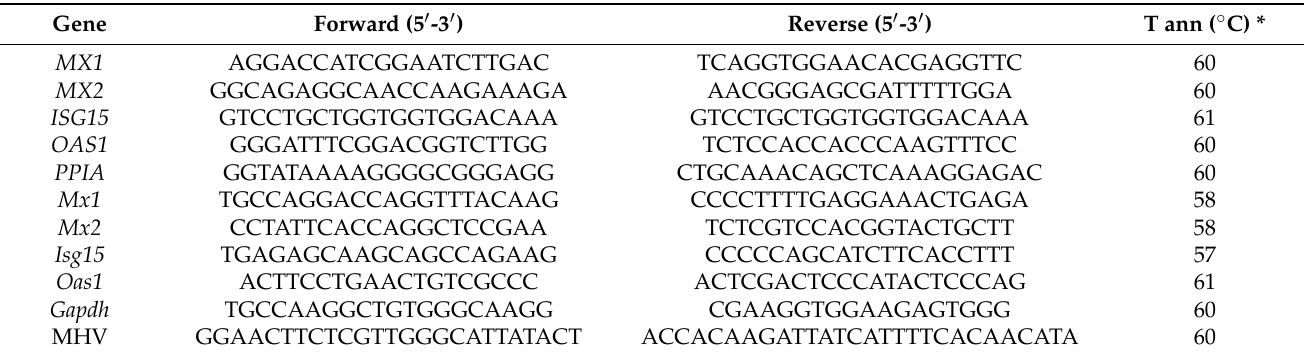
Table 1. List of primers used in